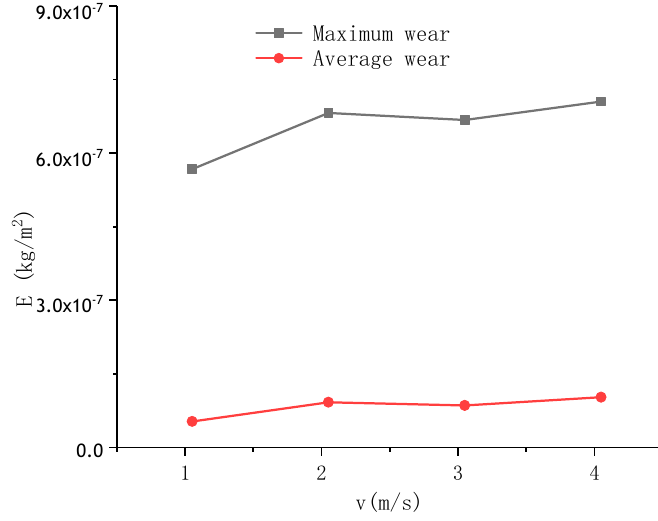
Figure 16. Wear curve of test samples at different particle inlet velocity.